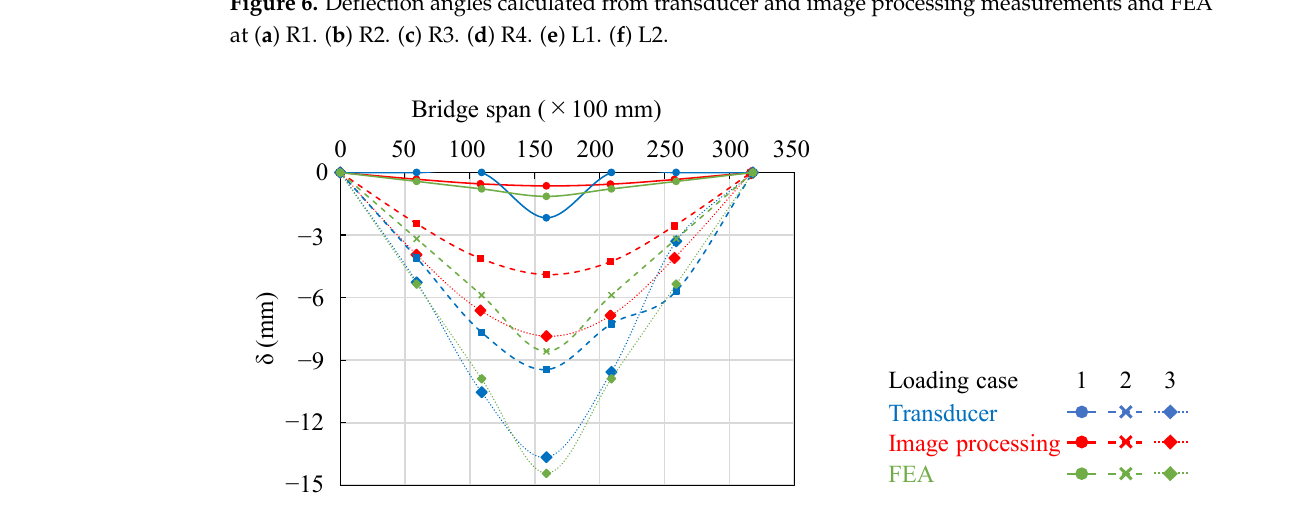
Figure 7. Mean deformation profiles under loading cases 1, 2, and 3 along the five targets on the bridge